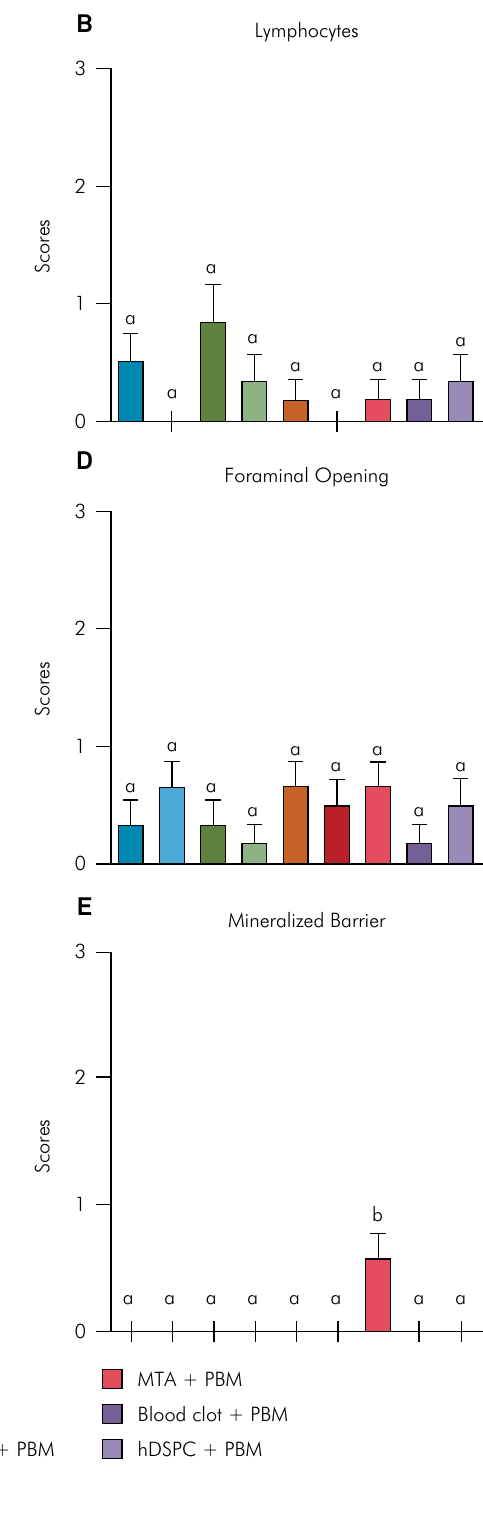
Different lowercase letters indicate statistically significant difference (p < 0.05). Figure 3. Graphic representation of the comparison between groups for (A) neutrophils, (B) lymphocytes, (C) fibrous condensation, (D) foraminal opening, (E) mineralized tissue formation, and (F) mineralized